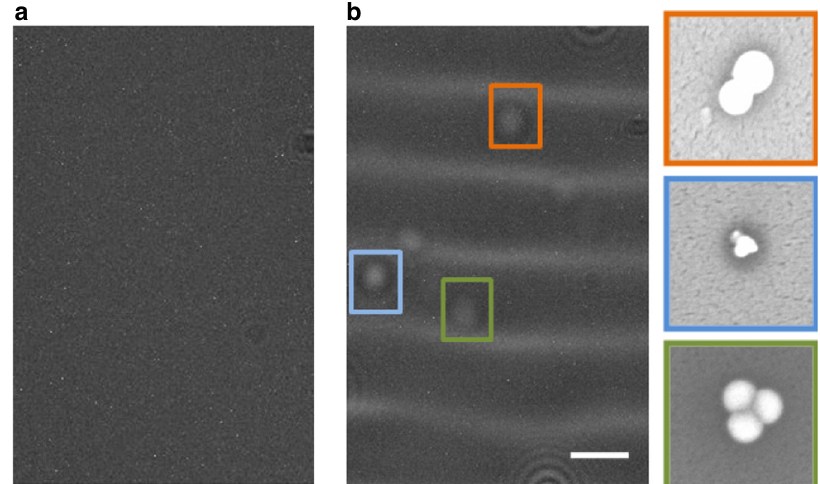
Fig. 5 Nanoparticle detection. Lens-free holographic detection of 200 nm polystyrene nanoparticles both a before and b after acoustic actuation. Scale bar for the lensfree image is 100 µ m. The colored insets in ( b ) show the SEM images of the corresponding nanoparticles. The fi eld-of-view for SEM images is 1 µ m × 1 µ